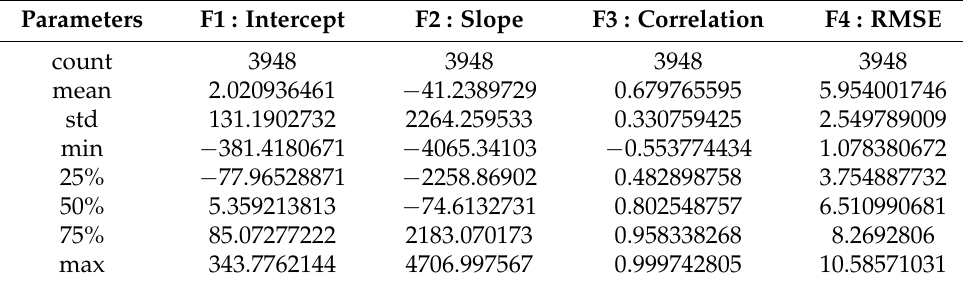
Table 5. Statistical information of ZCP dataset with noise level from 5% to 20%.